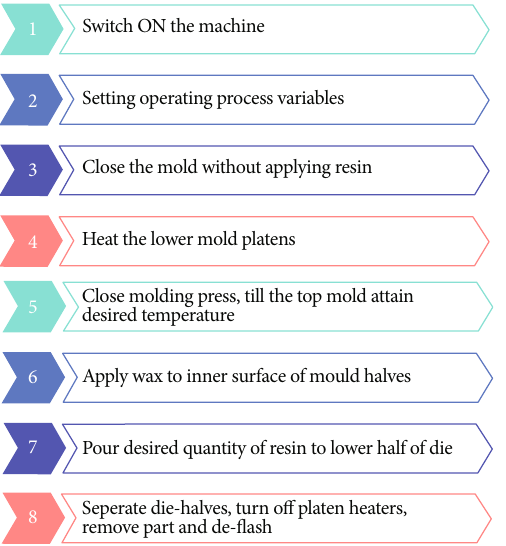
Figure 3: Steps involving the compression molding process for producing hybrid composites. Table 3: Fabrication of